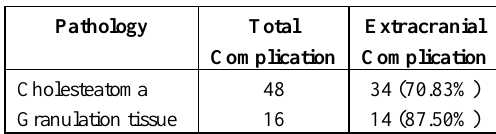
Table IV. Comparison of types of pathology